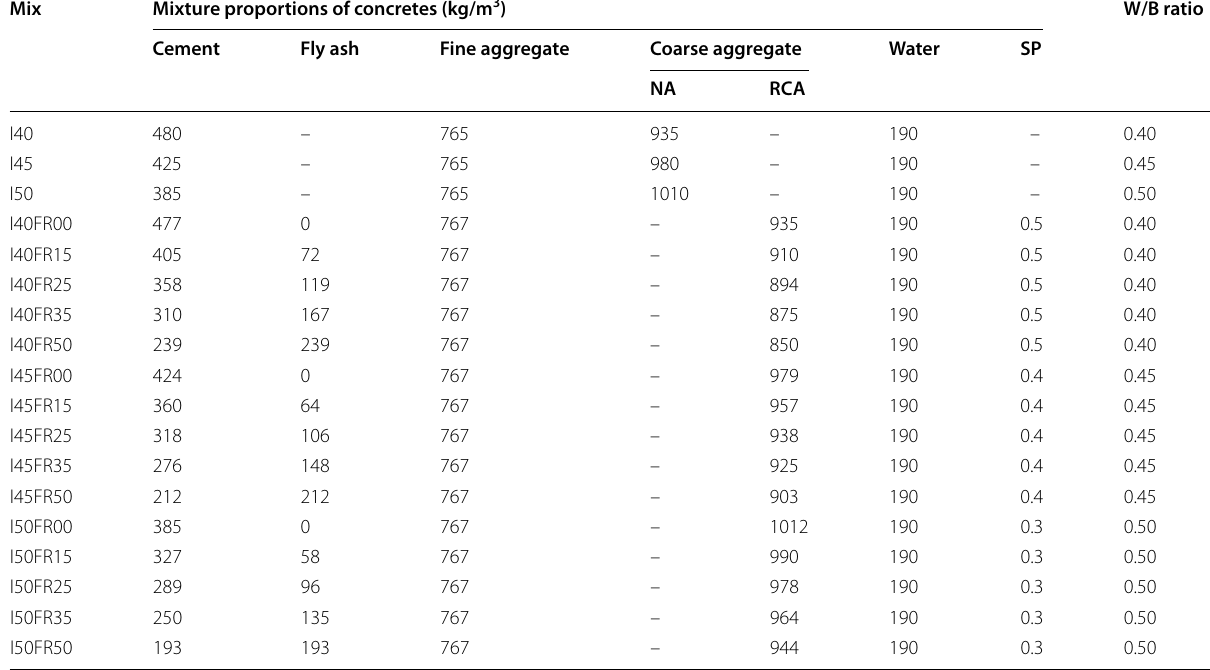
Table 3 Mixture proportions of NA and RCA